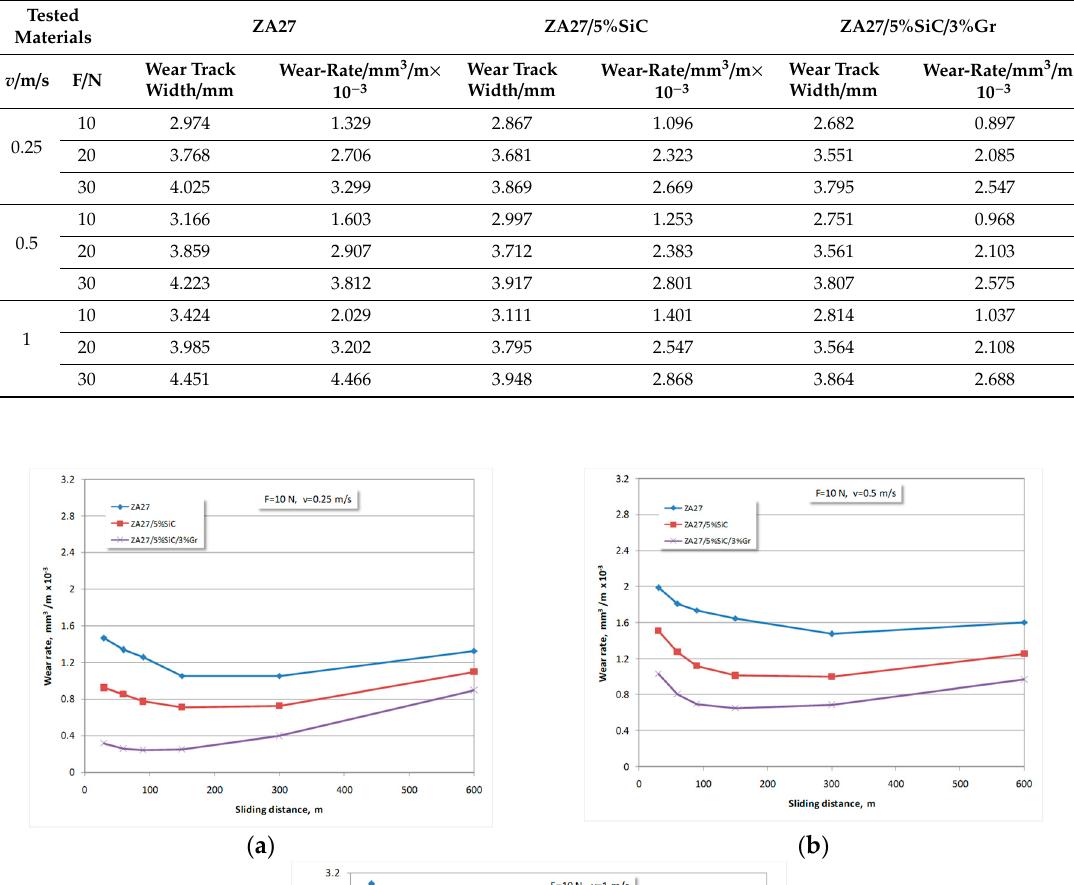
Table 2. Values of wear track width and wear-rate.